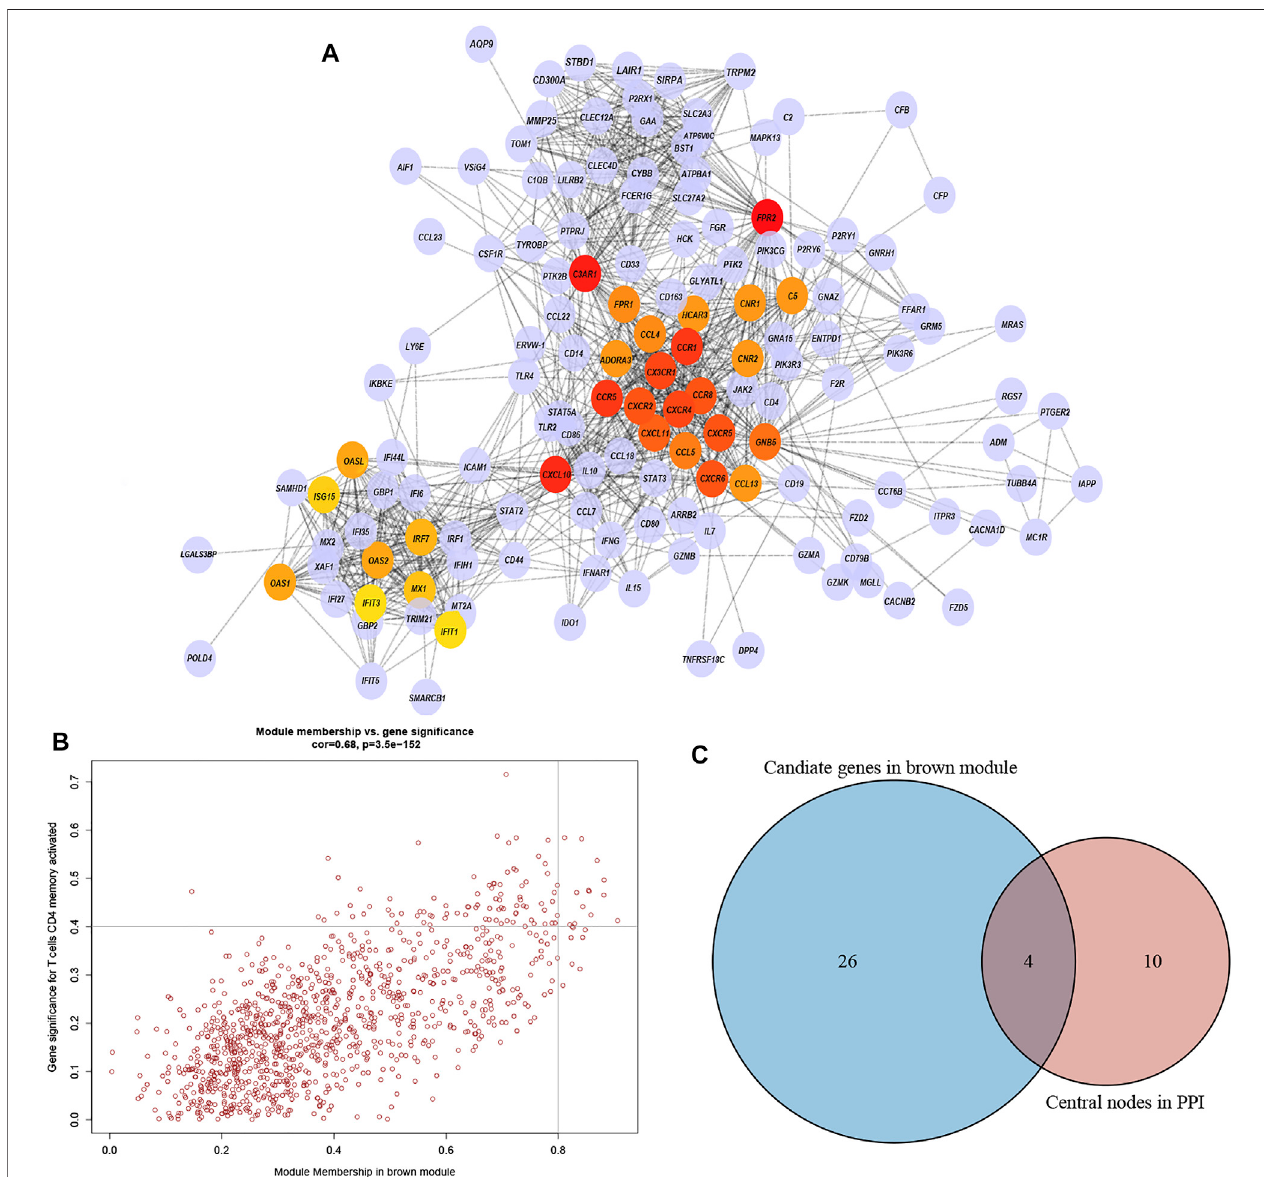
FIGURE 5 | PPI network and identi fi cation of the hub genes. (A) PPI network from the brown module. The higher the number of connected nodes, the deeper the color of the nodes. (B) A scatter plot of the genes in the brown module. Each brown node represented a gene, and dots within the top right corner indicate Gene Signi fi cance > 0.4 and Module Membership > 0.8. (C) Hub genes were selected based on the overlap between PPI essential nodes and candidate genes of